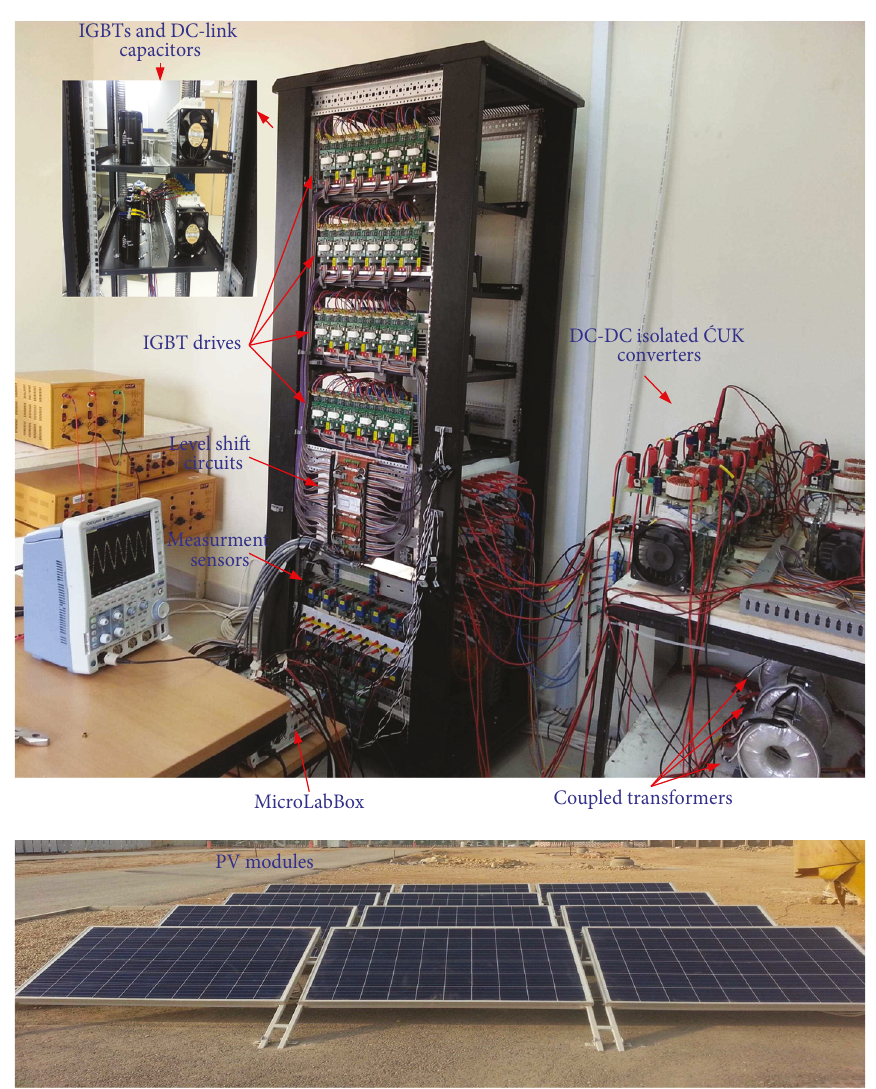
Figure 15: Hardware setup of the proposed topologies.